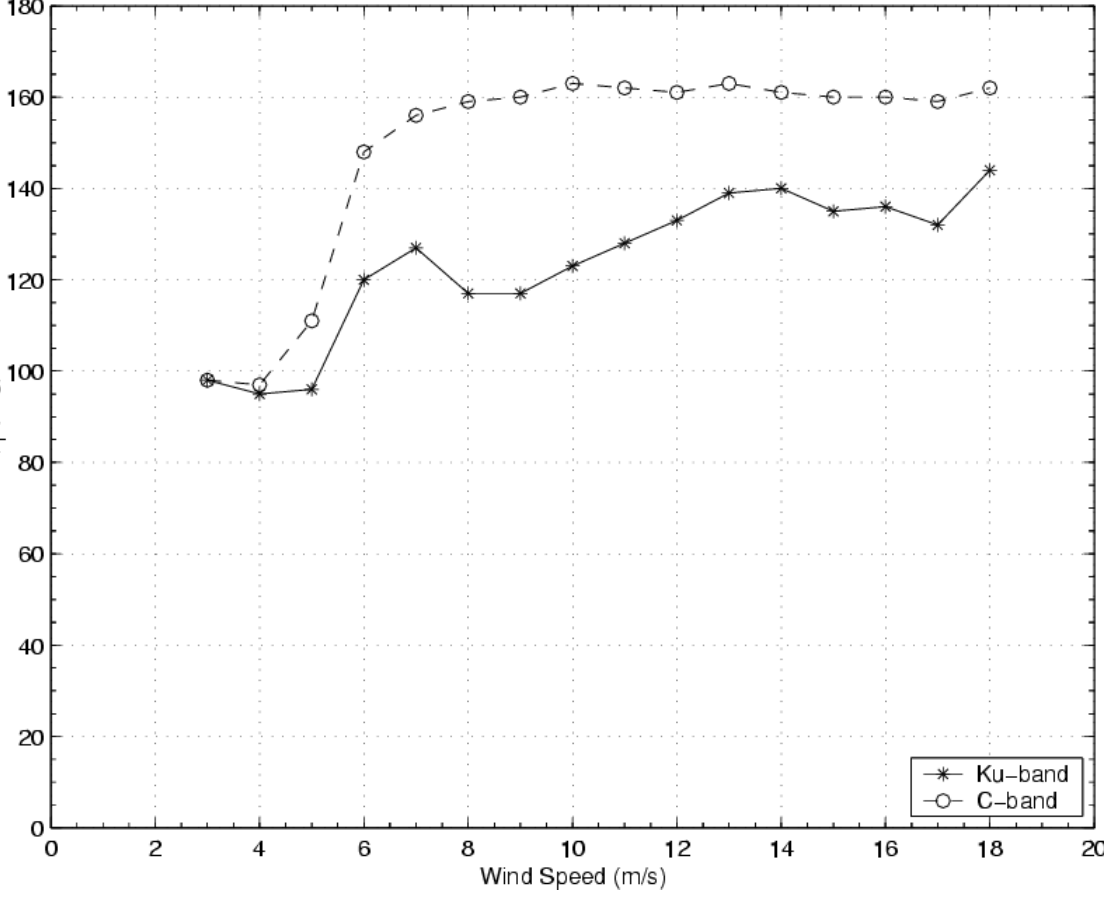
Figure 4 . Variation of azimuth angle shift φ , corresponding to the direction of maximum 1 backscatter signal, as a function of wind